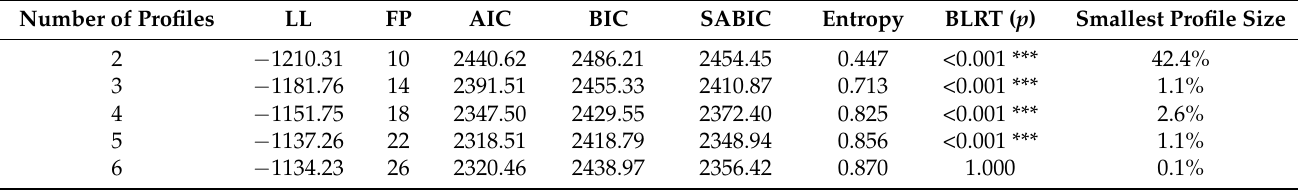
Table 2. Fit indices for profile